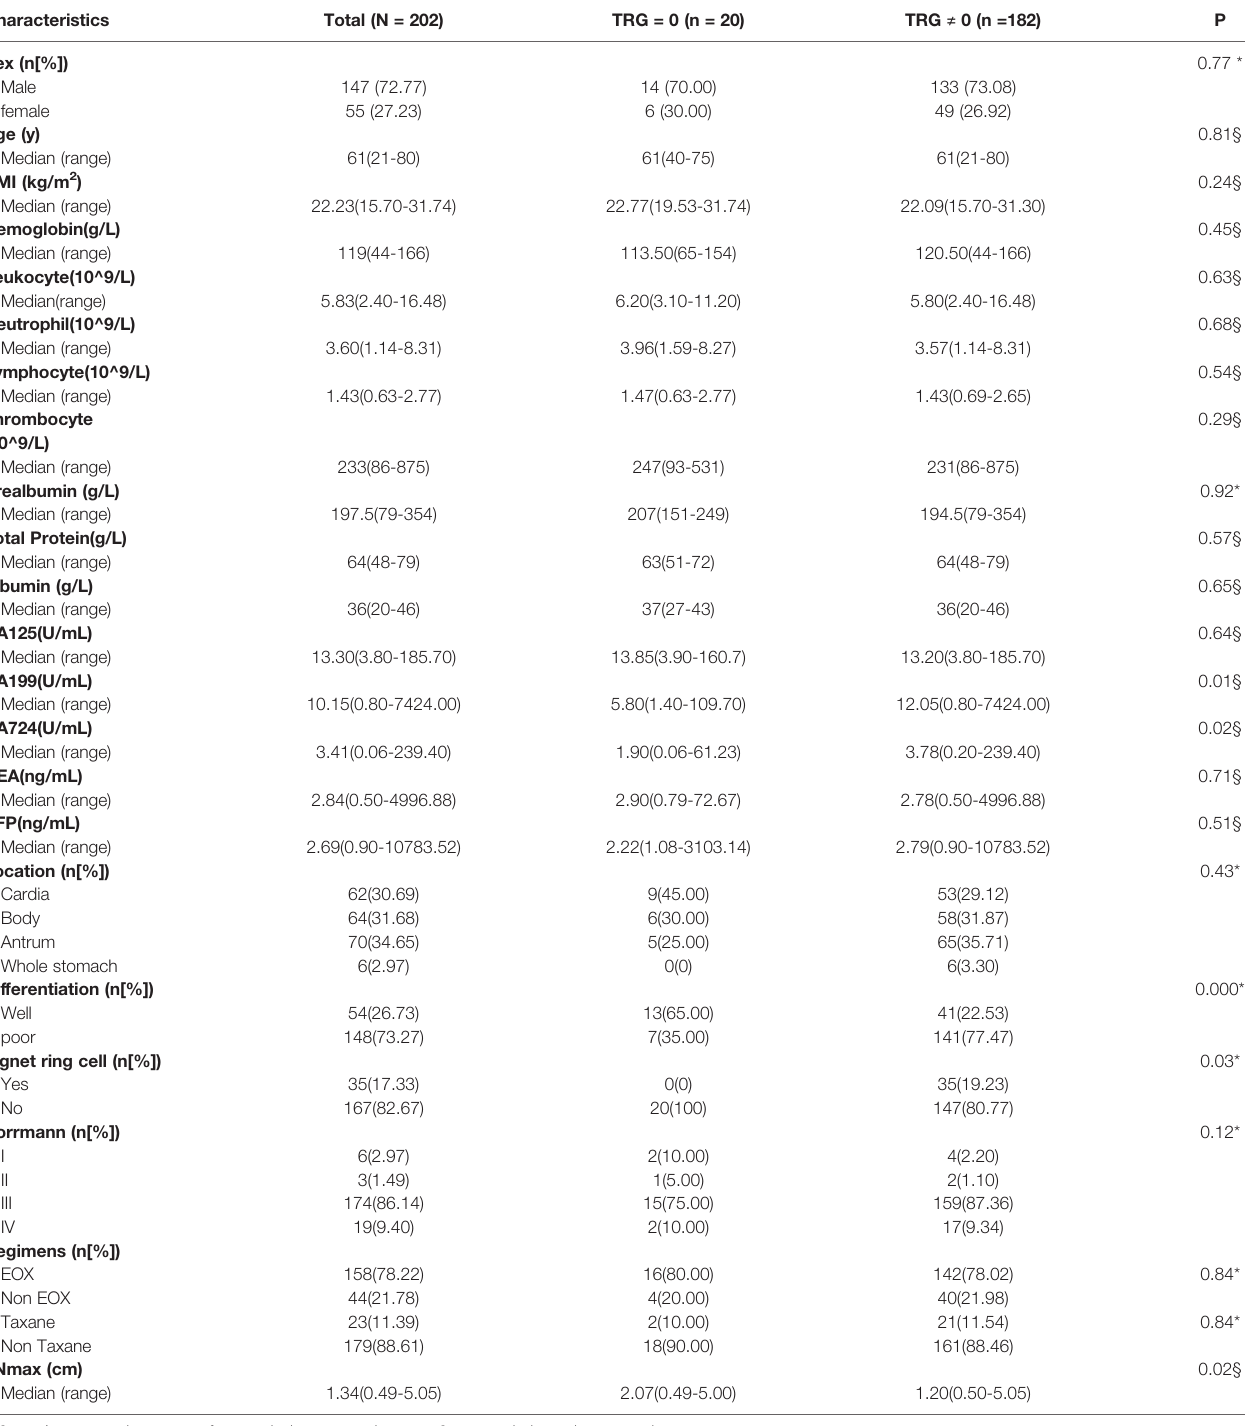
TABLE 2 | Univariate analysis: Characteristics in the Training Set.